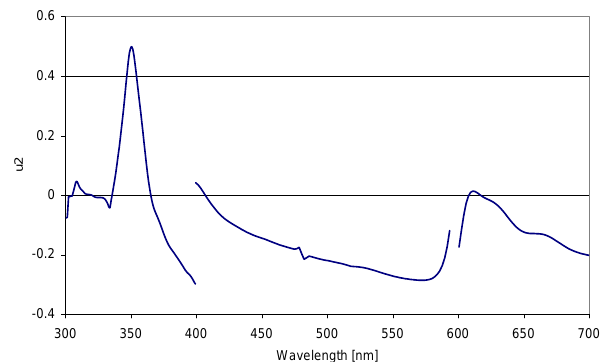
Fig. 2 Illustration of the wavelength dependent polarisation sensitivity of the SCIAMACHY Fig. 2. Illustration of the wavelength dependent polarisation sensi- instrument. Displayed is the so-called u2-vector, the ratio of the Müller matrix elements for tivity of the SCIAMACHY instrument. Displayed is the so-called one polarisation direction and unpolarised light [Slijkhuis et al., 1999]. The u2 vector is based on the version 3.1 keydata [Noël et al., 2005]. u 2-vector, the ratio of the M¨uller matrix elements for one polarisa- tion direction and unpolarised light (Slijkhuis et al., 1999). The u 2 vector is based on the version 3.1 keydata (No¨el et al.,